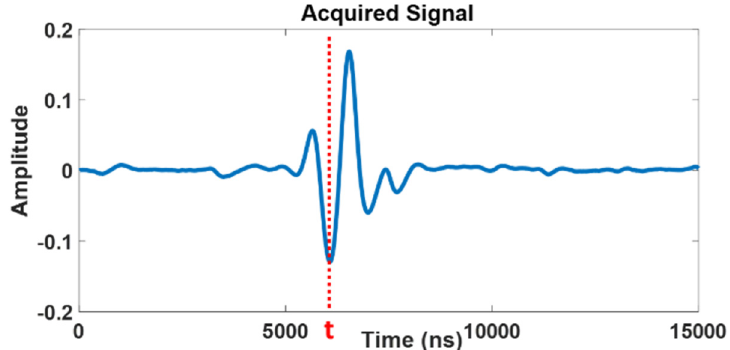
Fig. 13. Rayleigh wave average signal by EMAT.